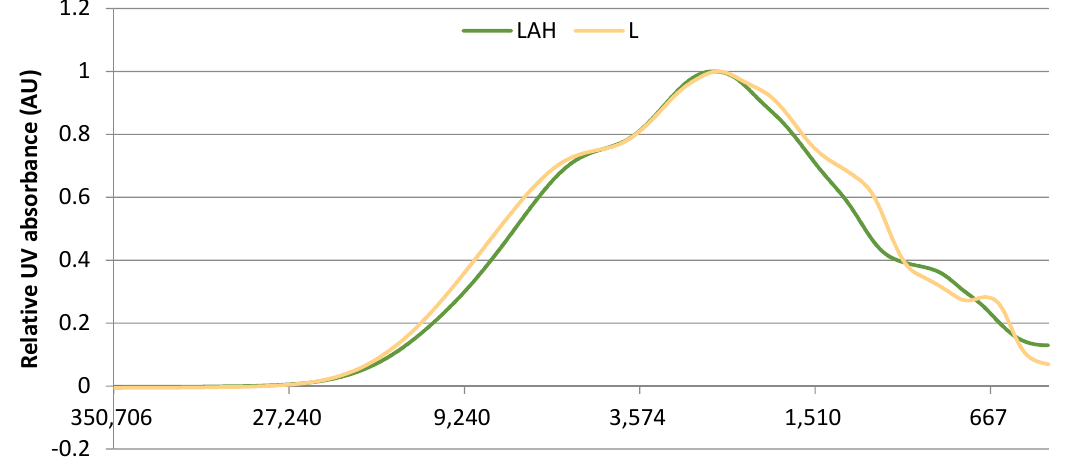
Figure 2. Normalized molecular weight distribution of lignin before (L) and after (LAH) acid hydrolysis of hot-water